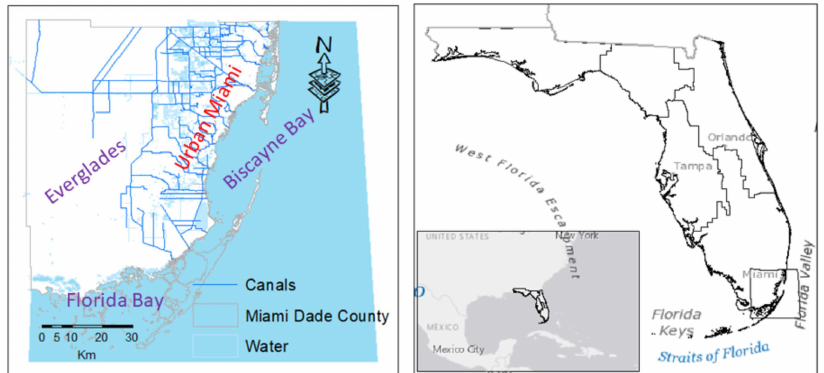
Figure 1. Location map of the study area, Miami-Dade County, and the Everglades. Source: SFWMD (South Florida Water Management District)-20004 and regional layers are from the ESRI (Environmental Systems Research Institute) base